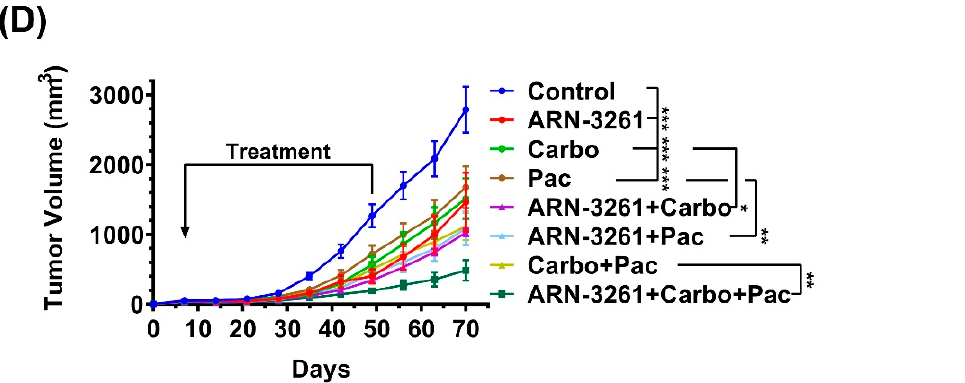
Figure 6. ARN-3261 enhances the activity of carboplatin in human ovarian cancer cell xenografts. ( A ) Design of xenograft experiments ( n = 10/group); ( B ) the combination of ARN-3261 and carboplatin inhibits tumor growth in an OVCAR8 i.p. model. After treatment as indicated in ( A ) for three weeks, mice were weighed, and intraperitoneal nodules were excised and weighed. ( C ) Design of xenograft experiments ( n = 10/groups); ( D ) The combination of ARN-3261 and primary chemotherapeutic drugs of carboplatin and paclitaxel inhibits tumor growth in an SKOv3 subcutaneous xenograft model. Mice were treated with single, double or triple agents for 6 weeks. Tumor was measured once a week until the tumor burden in control group reached maximum allowance. The graphs indicate the mean ± standard deviation. Statistical significance is indicated by * p < 0.05, ** p < 0.01 and *** p < 0.0001.